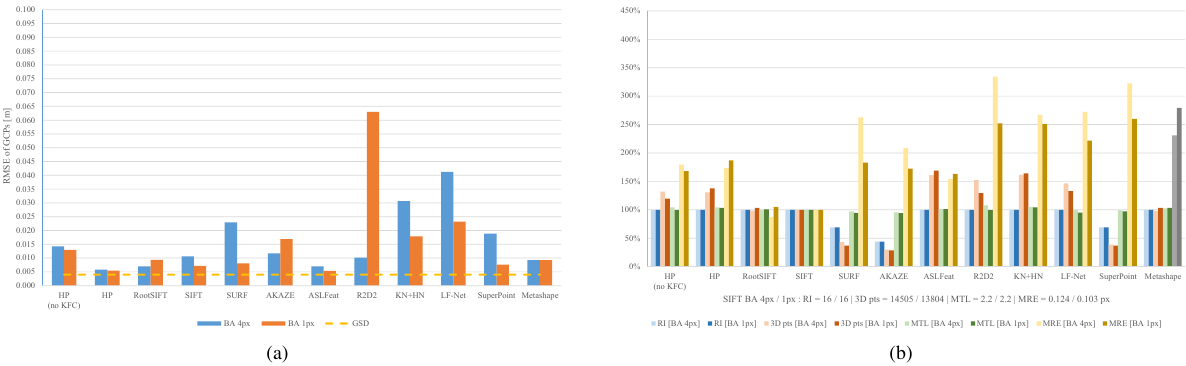
Figure 12. Paestum Wall Oblique dataset: (a) RMSEs of the CPs and (b) BA statistics as percentages with respect to SIFT values (RADIAL camera model with PP post-refinement, mTL=2). The min and max GSDs are reported with respect to the downsampled